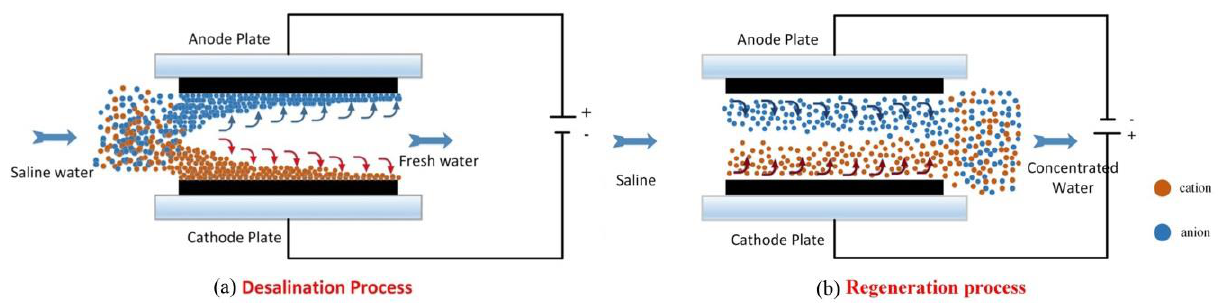
Figure 1. Electrosorption desalination ( a ) and the regeneration process ( b ) diagram.